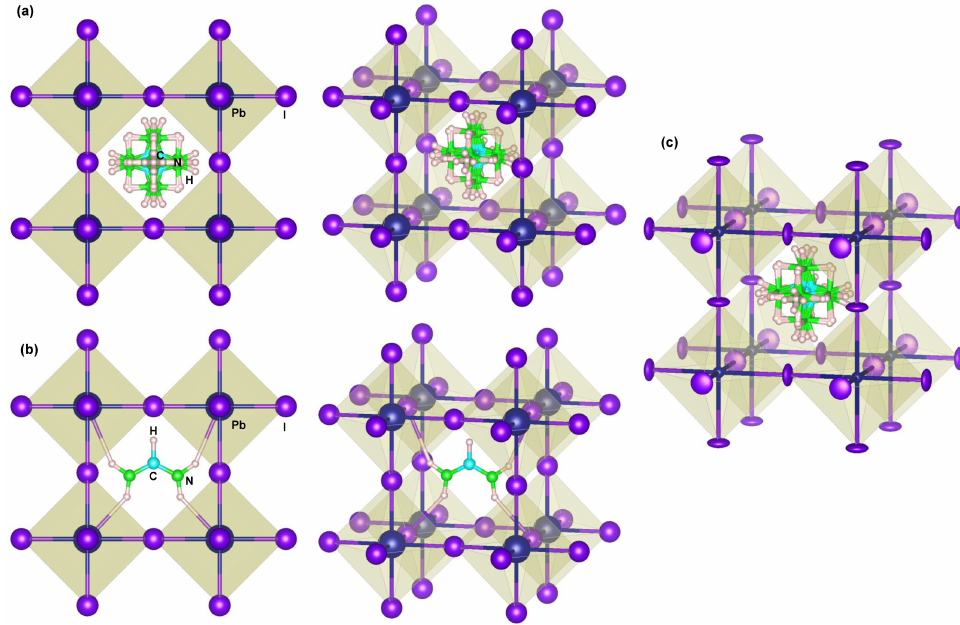
Figure 17: (a) Averaged and (b) local structural models of HC(NH 2 ) 2 PbI 3 . (c) Atomic displacement parameter ellipsoids shown at 50% proba- bility of (a).